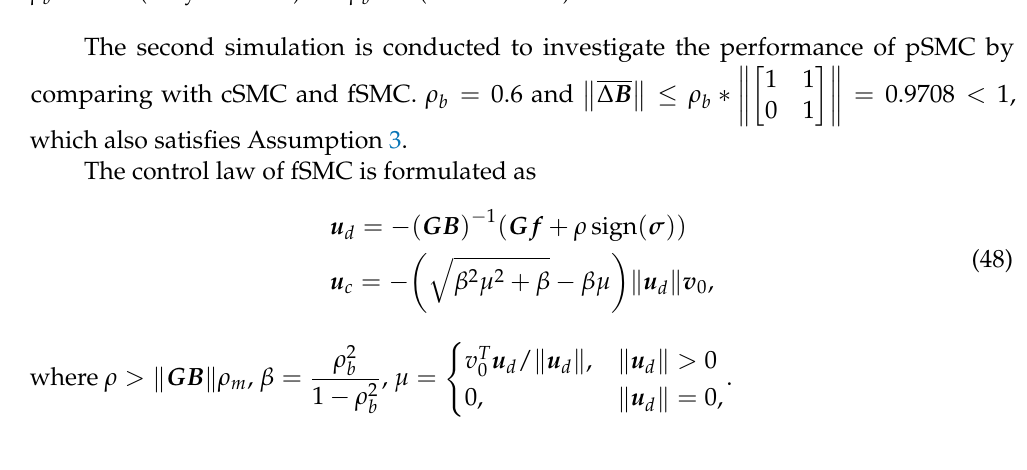
Figure 10. The control variable performance of the system controlled by cSMC in the cases of ρ b = 0.607 (Gray solid line) and ρ b = 0 (Red solid